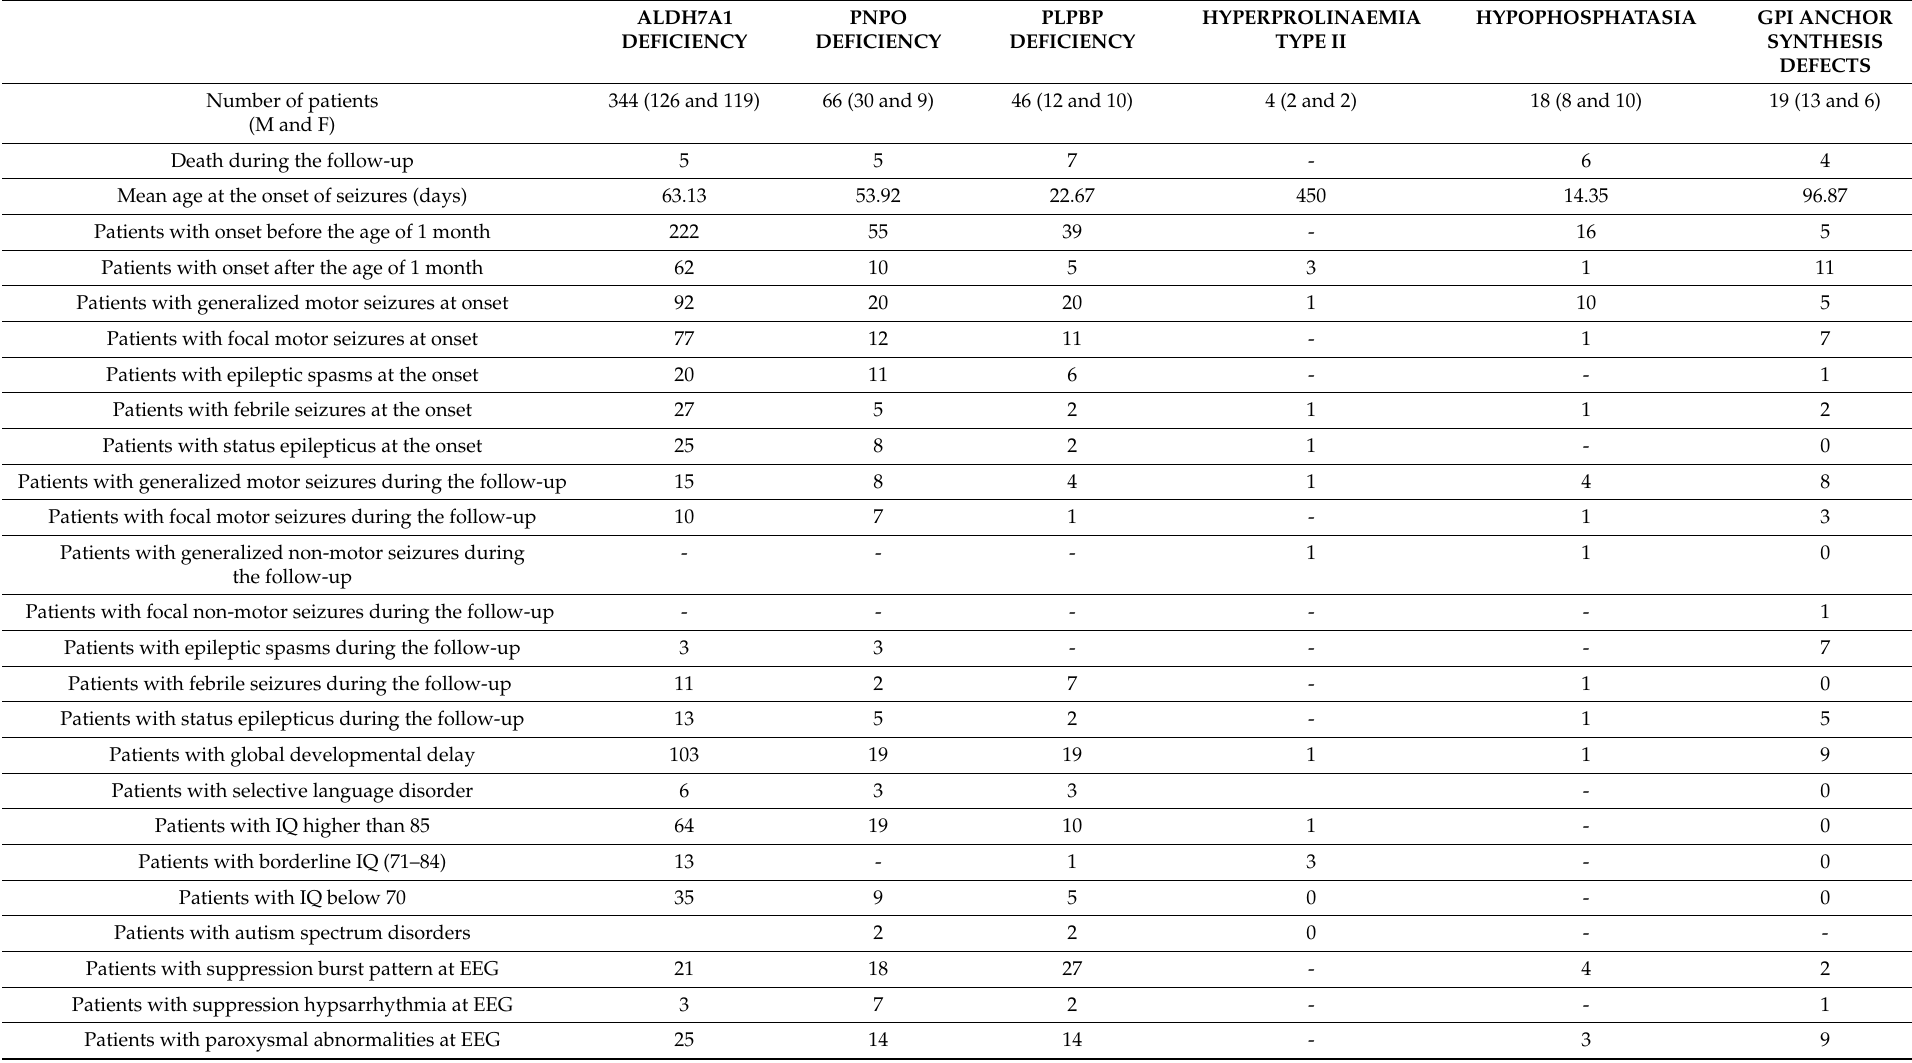
Table 2. Demographic, developmental, and epileptological features of published patients with vitamin-dependent